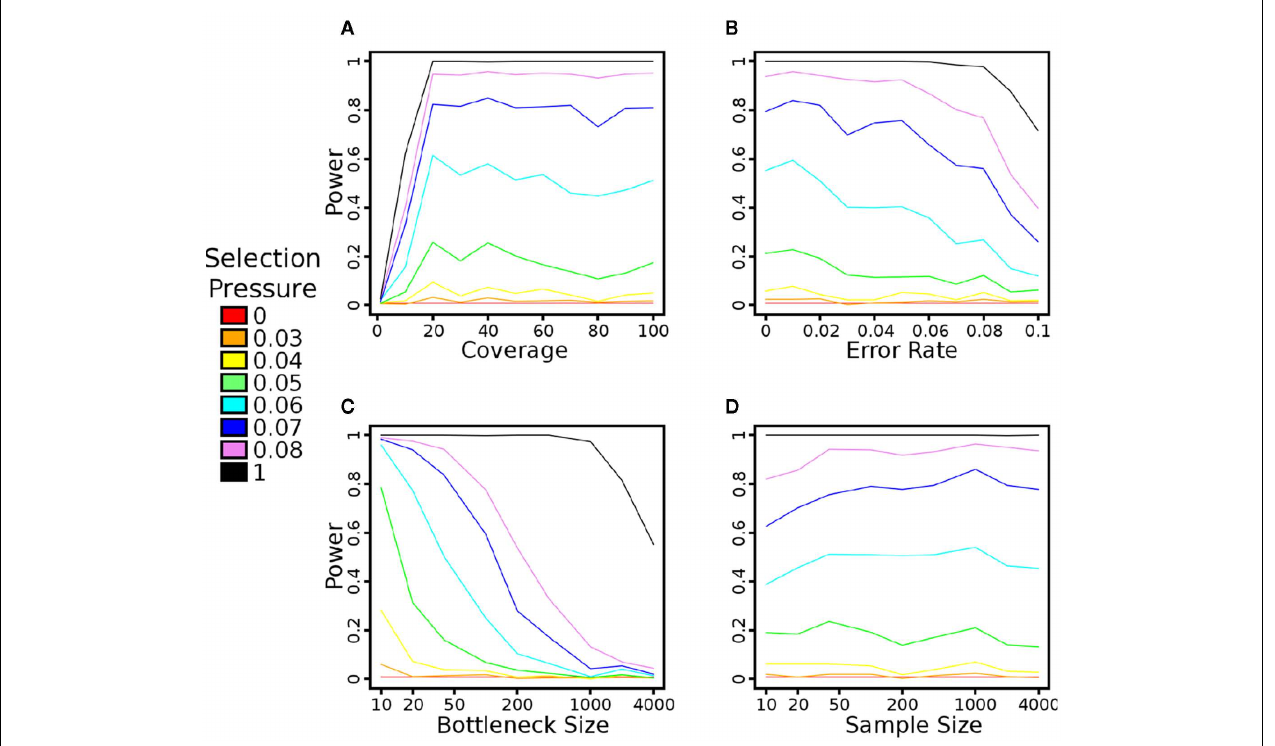
10% MAF, the statistic is robust to reasonable levels of error. (C) The impact of founder population size on power.The beneficial allele is present in exactly one haplotype in each setting, so this also represents the impact of the beneficial allele’s initial frequency on power. As expected, a low initial frequency (and high initial haplotype diversity) leads to a loss of power. (D) The impact of sequencing sample size on power.This parameter does not have a major impact on power – even 10 individuals are sufficient to determine signatures of selection in the